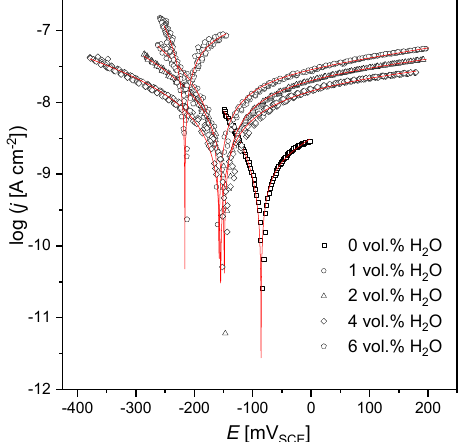
Figure 1. Open-circuit potential for the AISI 1010 steel electrodes immersed in sulfolane containing up to 6 vol.% of water; V SCE is the electrode potential measured versus saturated calomel electrode.